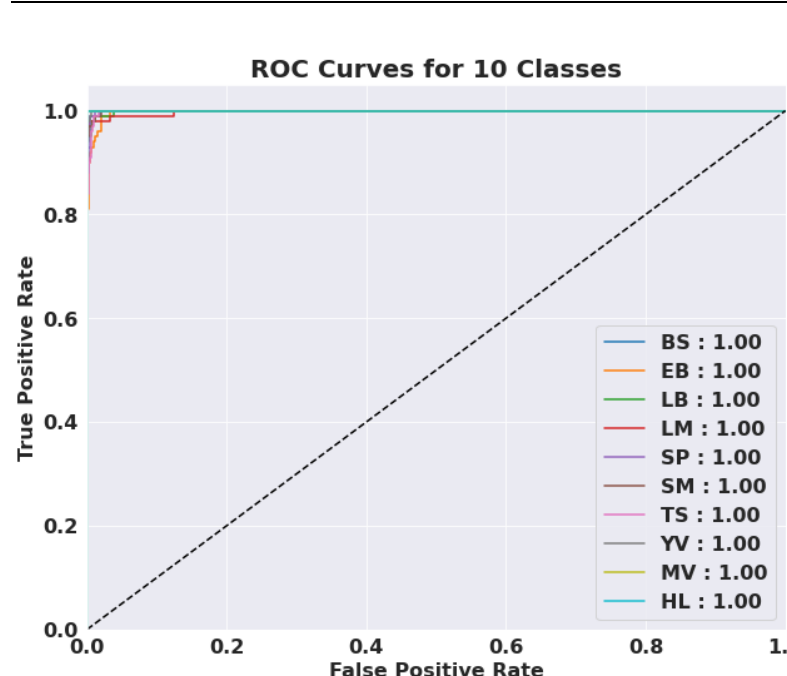
Figure 5. The AUC-ROC results of the proposed model with an AUC score of